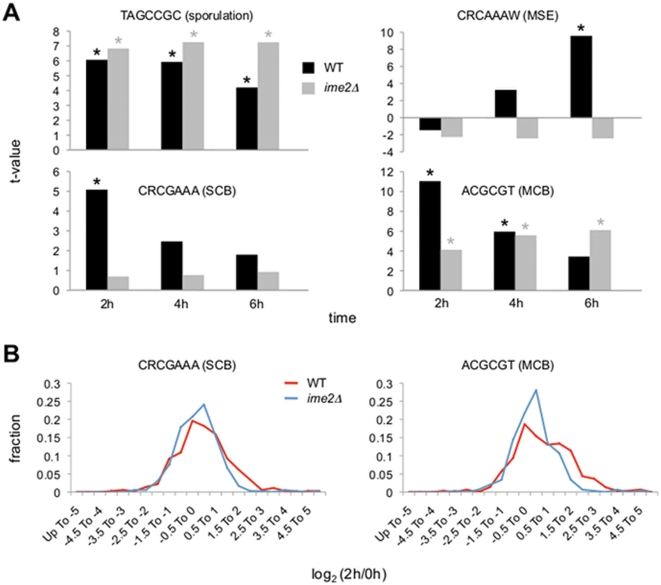
Analysis of consensus motif gene sets.
A, Gene expression data from our time course were analyzed by T-profiler for average expression of gene groups defined by consensus promoter motifs. Results for selected gene groups characterized by the indicated sequences are shown (R = A or G; W = A or T). Comparisons were made between expression levels at 2, 4, and 6 h v. expression levels at 0 h. Asterisks indicate statistically significant values (E<0.05). B, Distributions of log2 (2 h/0 h) ratios for the CRCGAAA (left) and ACGCGT (right) gene sets are shown for WT and ime2Δ cells.